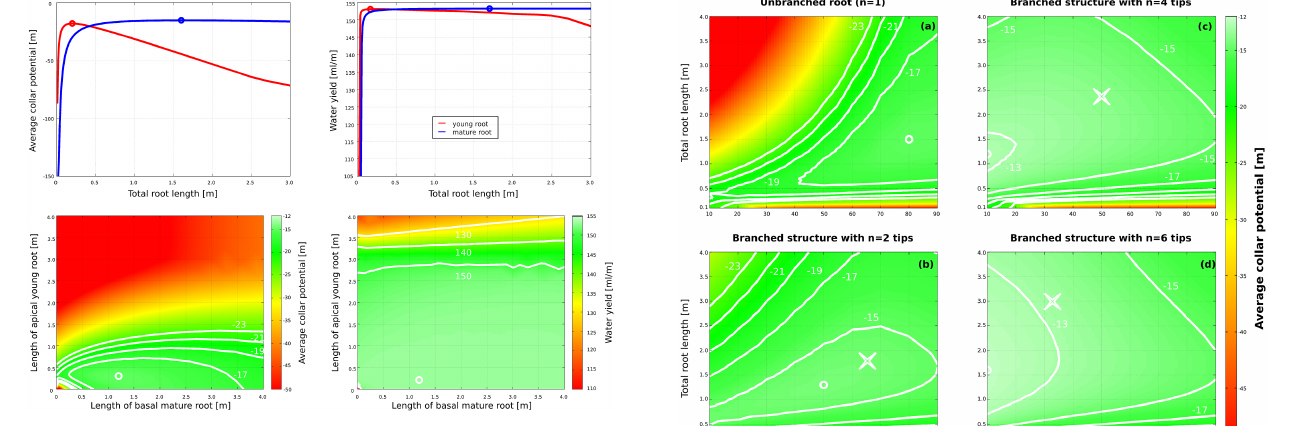
Figure 3. Effort ˜ w (left) and water yield ˜ v (right) in unbranched sin- gle roots, depending on the proportion of young and mature roots. Data was obtained with the simple model. Shown are effort and wa- ter yield for (top) unbranched homogeneous young (red) and mature (blue) roots over total root length and (bottom) for heterogeneous roots. Optimal values are indicated with circles.